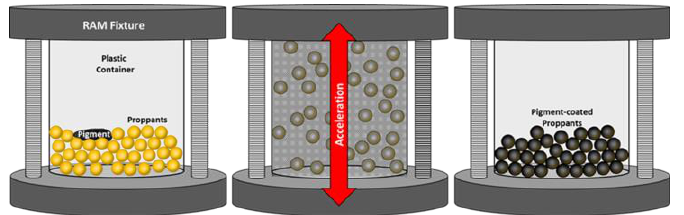
Figure 1. Schematic diagram of the RAM coating process and subsequent reaction sintering .